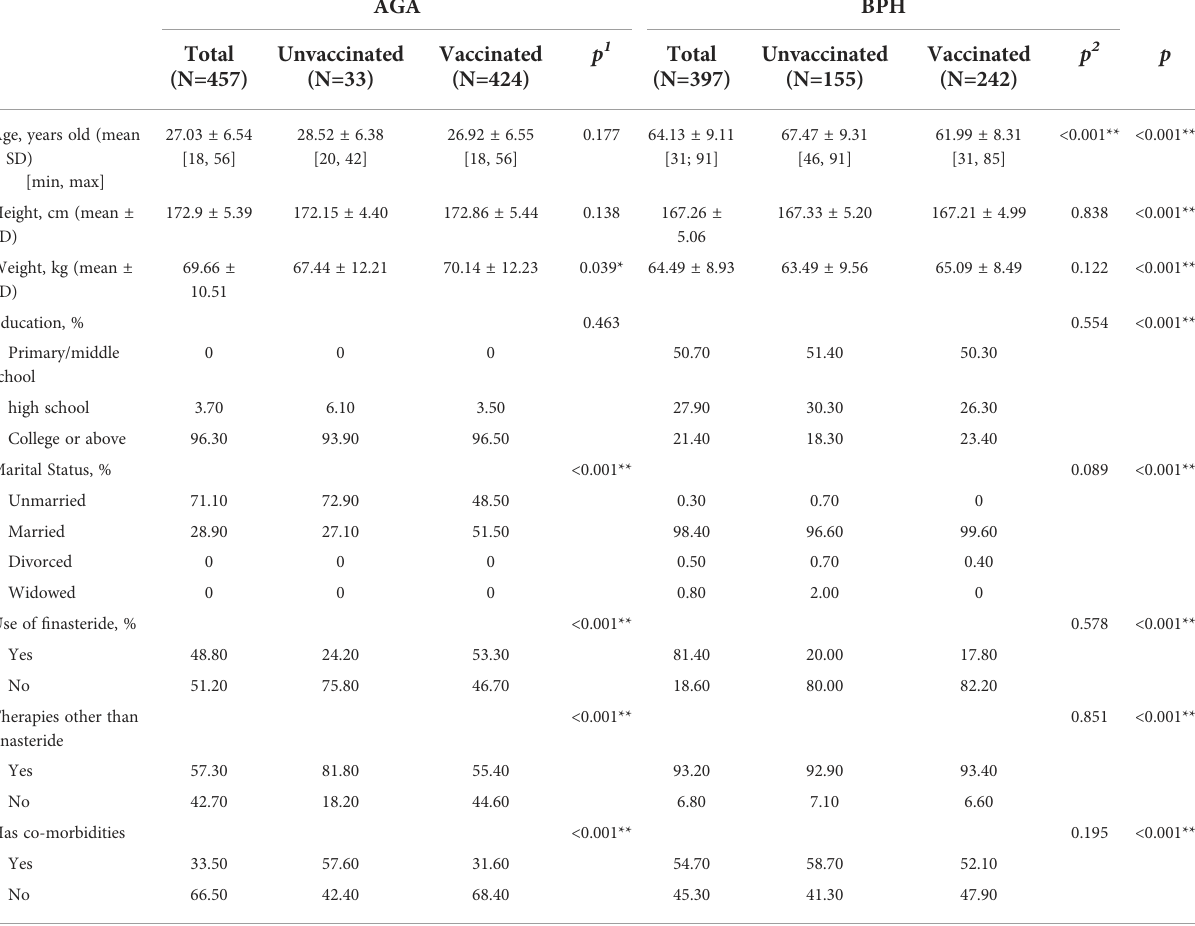
TABLE 1 Characteristics of AGA and BPH patients vaccinated and unvaccinated for